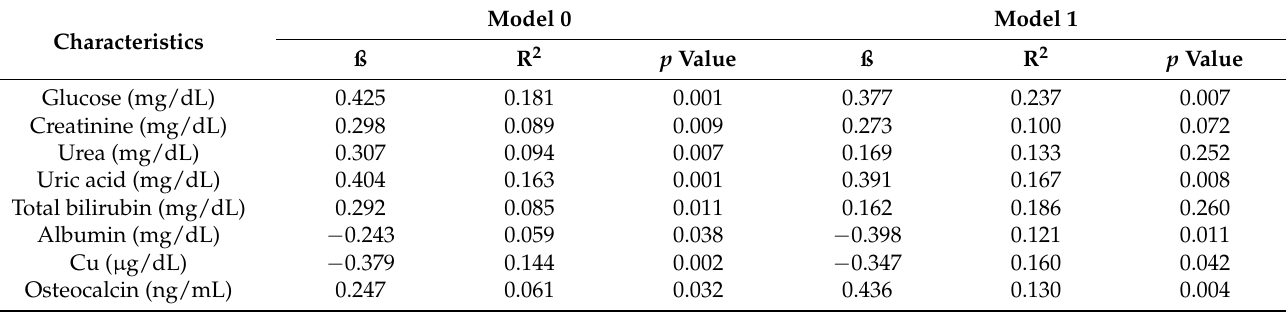
Table 3. Significant associations between age and the biochemical parameters of the